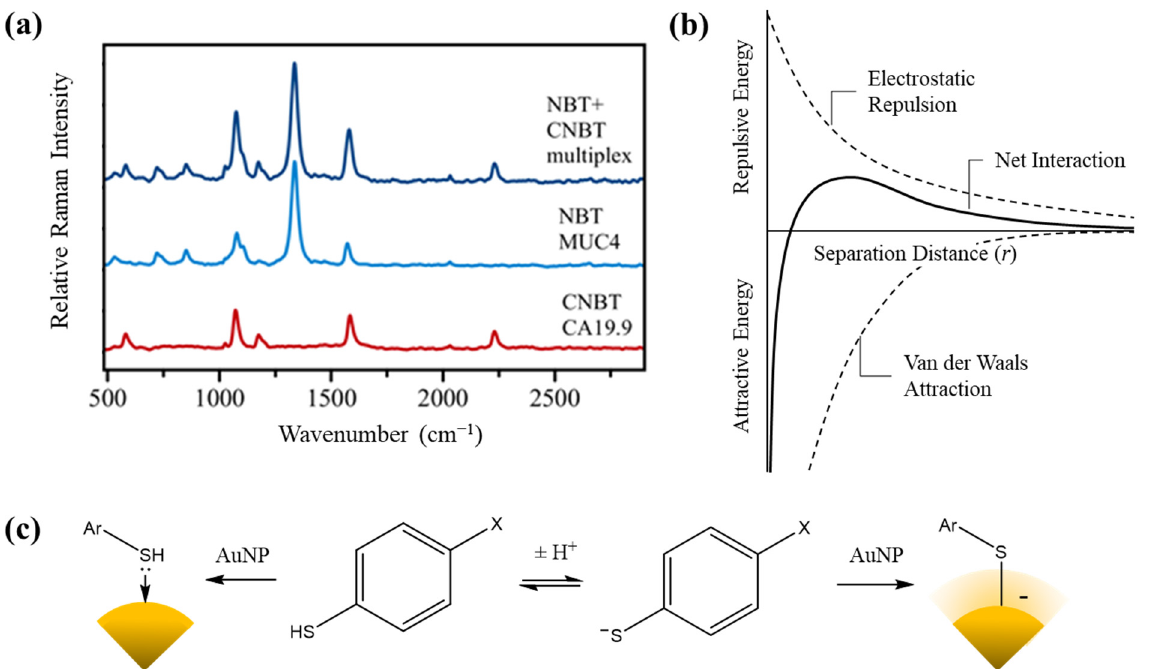
Figure 3. Multiplexed SERS spectra and schematics for interpretation of observed phenomena. ( a ) Raman spectra obtained from a sandwich SERS immunoassay for MUC4 and CA19-9 using CFPAC-1 cell line lysate. The spectra have been vertically shifted for clarity. Raman band assignment for NBT: 540 cm − 1 (benzene ring deformation), 724 cm − 1 ( ρ -NO 2 , rocking), 857 cm − 1 ( ν -NO 2 , scissoring), 1079 cm − 1 ( ν -CS, stretching), 1112 cm − 1 ( δ -CH, in-plane bending), 1136 cm − 1 ( ν -NO 2 , symmetric stretching), 1574 cm − 1 ( ν -CC, stretching). Raman band assignment for CNBT: 577 cm − 1 (benzene ring deformation), 1069 cm − 1 ( ν -CS, stretching), 1172 cm − 1 ( δ -CH, in-plane bending), 1580 cm − 1 ( ν -CC, stretching), 2225 cm − 1 ( ν -CN, stretching). ( b ) Qualitative representation of the potential energy diagram governing the interaction between colloidal particles described by DLVO theory. ( c ) A mechanistic model of the competing sulfur binding modes to gold surfaces. The central equilibrium determines the balance of thiol and thiolate species in solution. The binding of the neutral thiol results in no contribution of surface charge (left) while the thiolate confers negative charge (right).